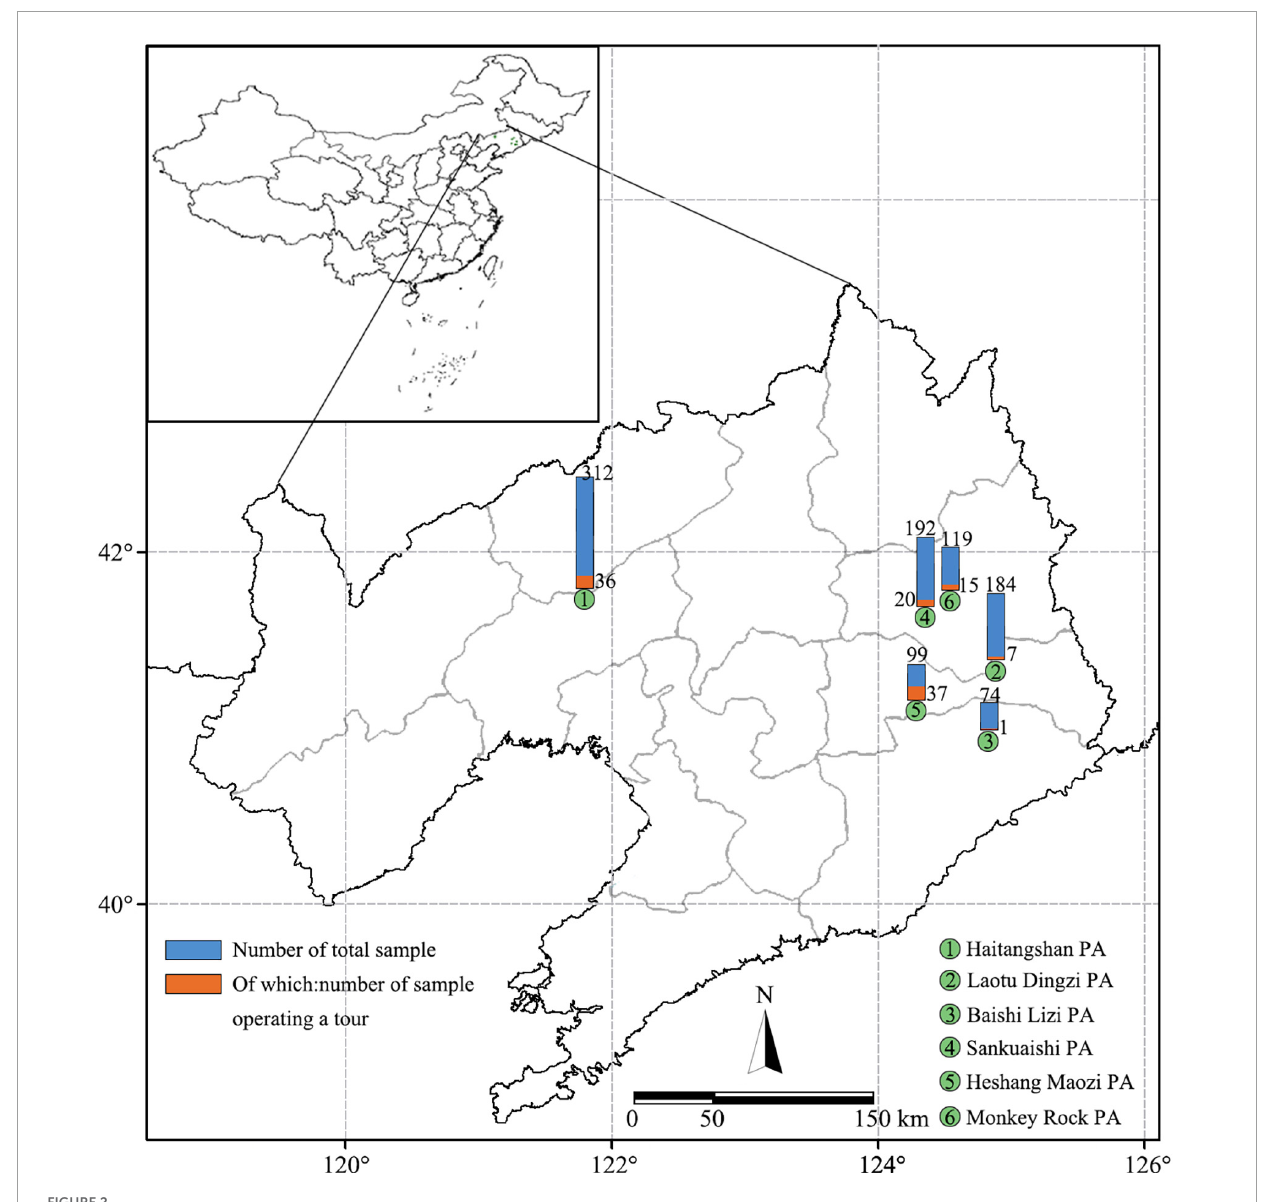
FIGURE2 Diagram of samples